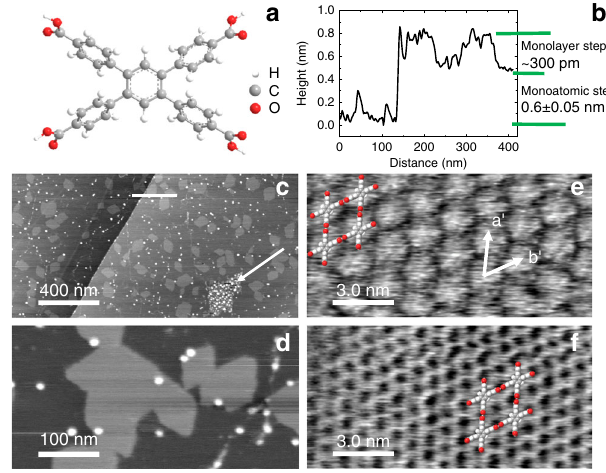
Fig. 7 Islands of 1,2,4,5-tetrakis(4-carboxyphenyl)benzene on the melamine cyanurate-terminated black phosphorus surface. a Structure of 1,2,4,5- tetrakis(4-carboxyphenyl)benzene (TCPB); b Pro fi le showing heights of monolayer TCPB islands and a BP terrace step as indicated in image c . c , d 2 µ m × 1 µ m and 500 nm × 250 nm, respectively, tapping mode AFM scans of TCPB islands; arrow in c shows an unterminated BP area which has degraded. These images were taken with Multi75Al-G probes using the fundamental resonance of 59.54 kHz; e Tapping mode AFM of a TCPB island showing individual molecules with lattice vectors a ’ and b ’ and schematic of hydrogen-bonded array overlaid. f Tapping mode AFM of the underlying CA.M network with TCPB lattice vectors and schematics overlaid. Images e , f were taken with Multi75Al-G probe using third harmonic of 1.107